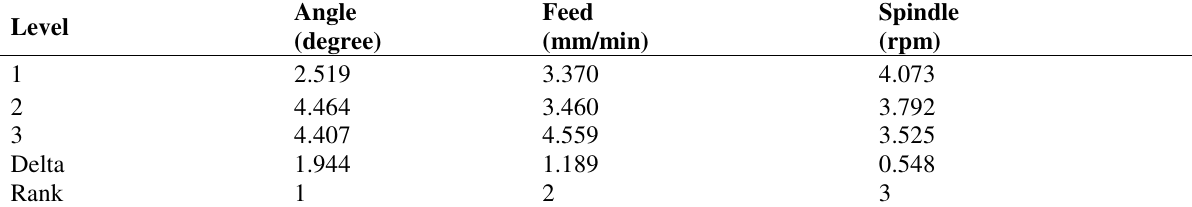
Response table for means for bronze .